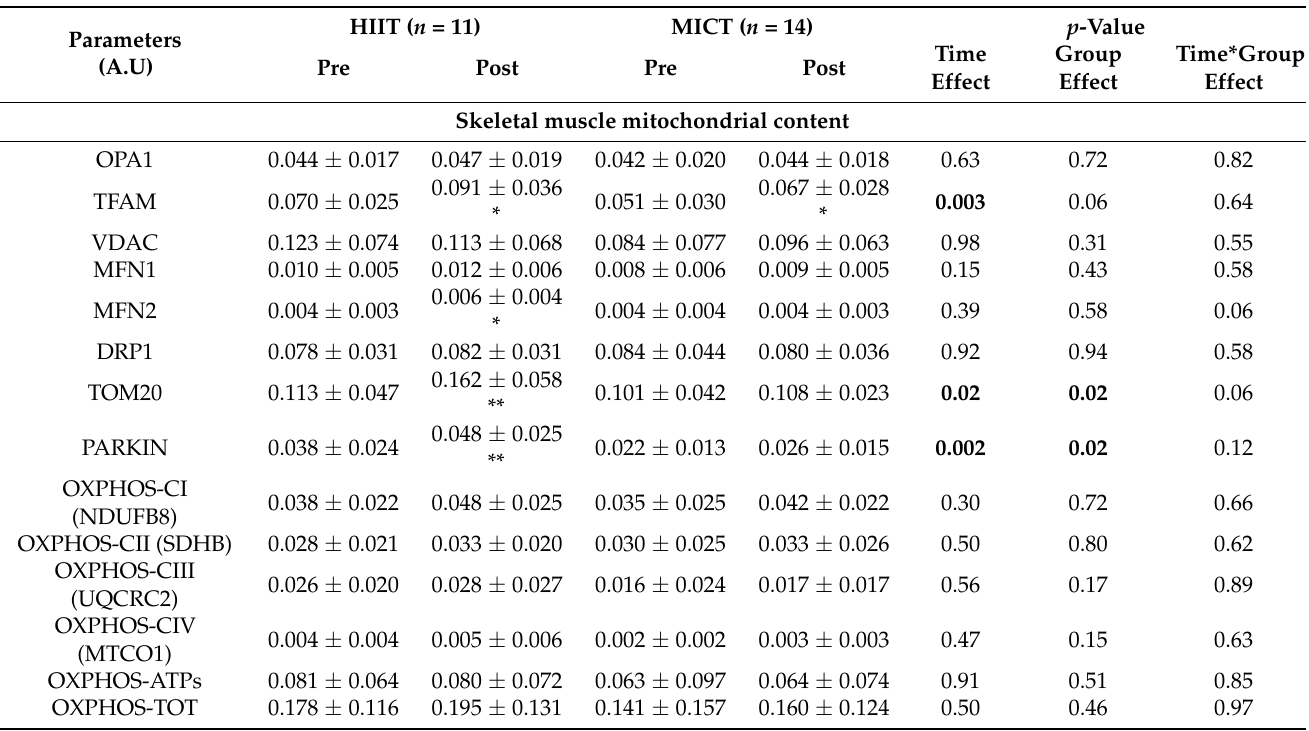
Table 5. Skeletal muscle mitochondrial content in obese older adults following 12 weeks of High- Intensity Interval Training (HIIT) and Moderate-Intensity Continuous Training